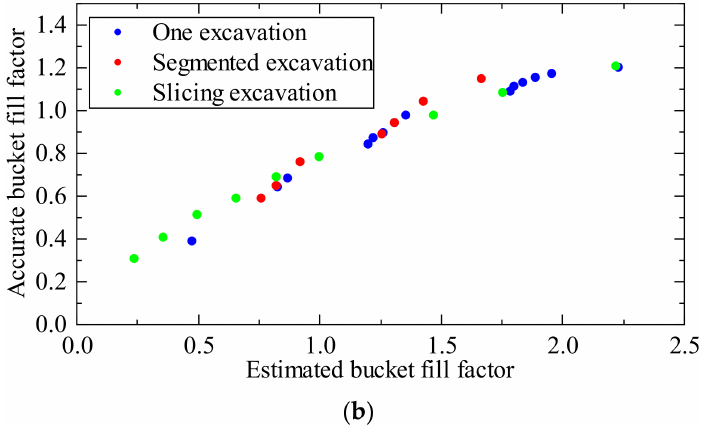
Figure 11. Scatter plot of predicted bucket fill factor under different fitting surface methods. ( a ) Poly- nomial surface fitting; ( b ) Neural network surface fitting.